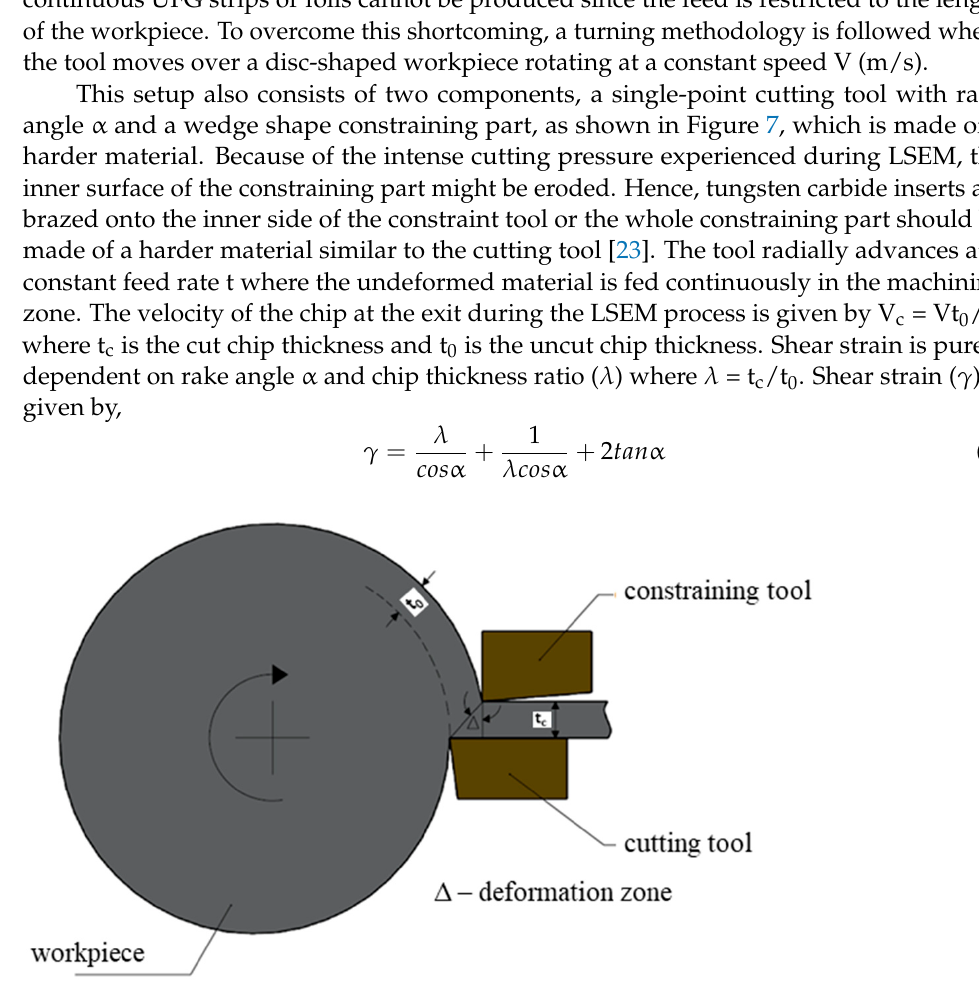
Figure 7. Schematic of turning approach in LSEM